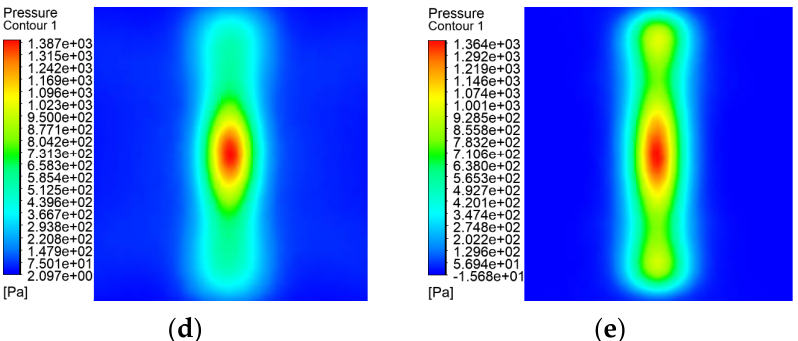
Figure 11. Distributions of the pressure near the wall. ( a ) Plane spraying pressure. ( b ) Outer surface busbar spraying pressure. ( c ) Circumferential spraying pressure on the outer surface. ( d ) Inner surface busbar spraying pressure. ( e ) Circumferential spraying pressure on the inner surface.